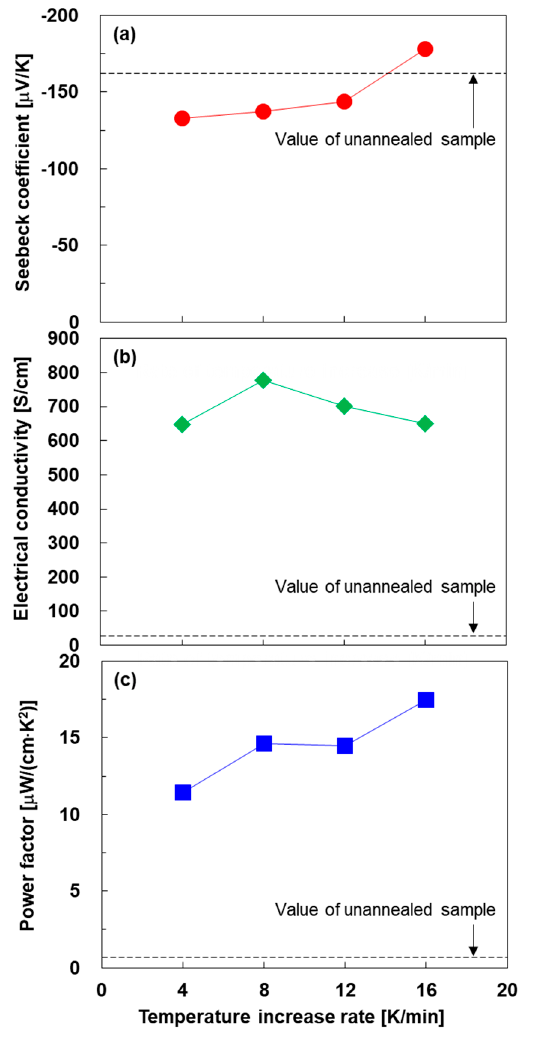
Figure 5. In-plane measured electrical transport properties of the Bi 2 Te 3 thin films: ( a ) Seebeck coefficient, ( b ) electrical conductivity, and ( c ) power factor. coefficient, ( b ) electrical conductivity, and ( c ) power